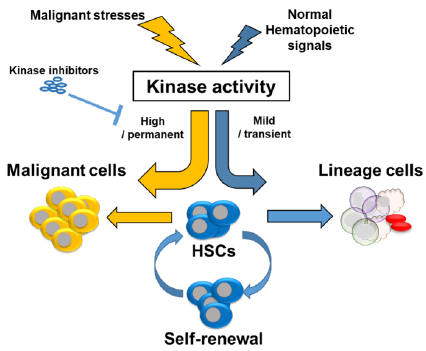
Figure 2. Fate decision of HSCs by kinase signaling. Normal hematopoietic signals moderately activate kinase signaling pathways of HSCs to self-renew or to differentiate into lineage cells. However, malignant stresses strongly or permanently activate kinase signaling pathways of HSCs and subsequently induce hematopoietic malignancies.